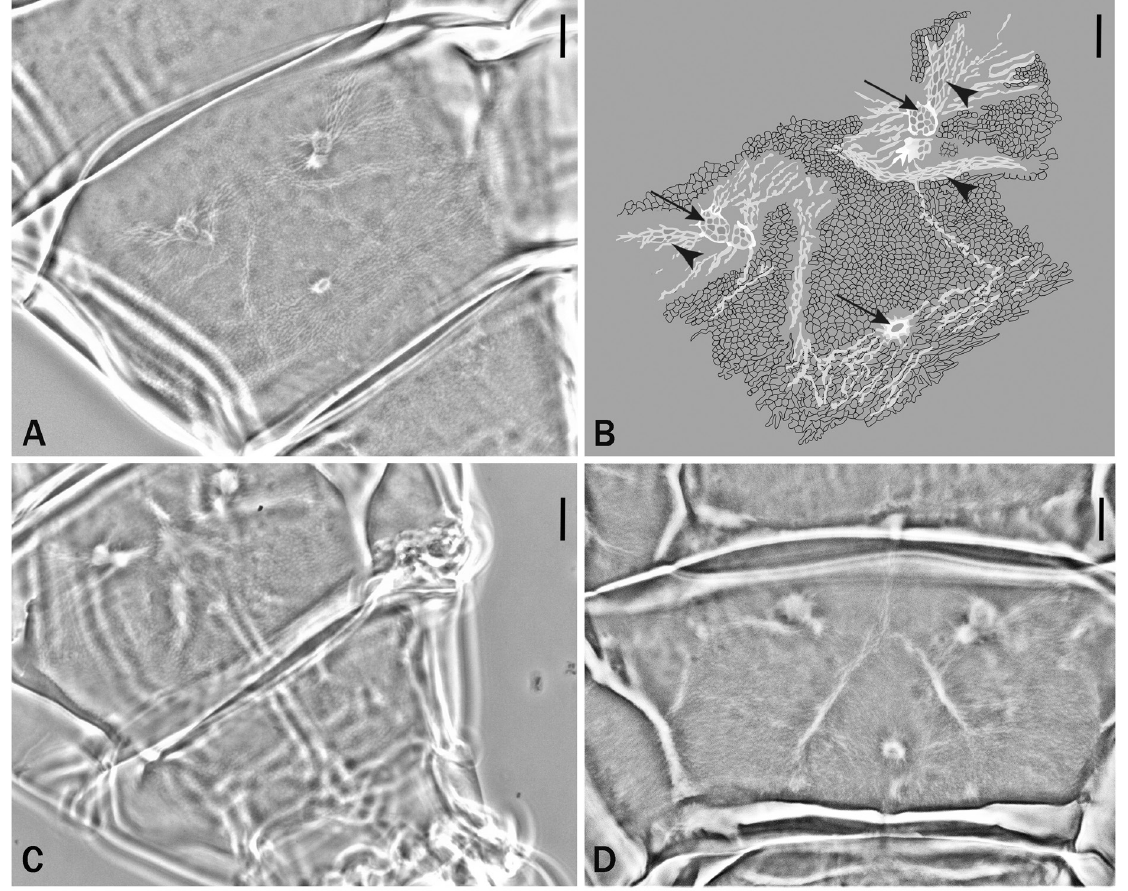
Fig. 16. Milnesium irenae sp. nov. A–B . Paratype, ♀ (slide No. UNLPam 1367-1). C . Paratype, ♀ (slide No. MCNS tar. 000023-2). D . Paratype, ♀ (slide No. UNICT 5899). Details of the cuticular ornamentation of the caudal segments (where it is more evident). A . Muscular attachments, grooves and rugosity arrangement, and, partially, the reticular pattern, are visible. B . Schematic drawing based on A, showing all components of the ornamentation: muscular attachments (arrows), grooves and rugosity system (in light grey) which forms crossings in some areas (arrowheads), reticular pattern. C . The reticular pattern is well visible. D . All cuticular sculpture components as in A are shown in another paratype. Scale bars = 10